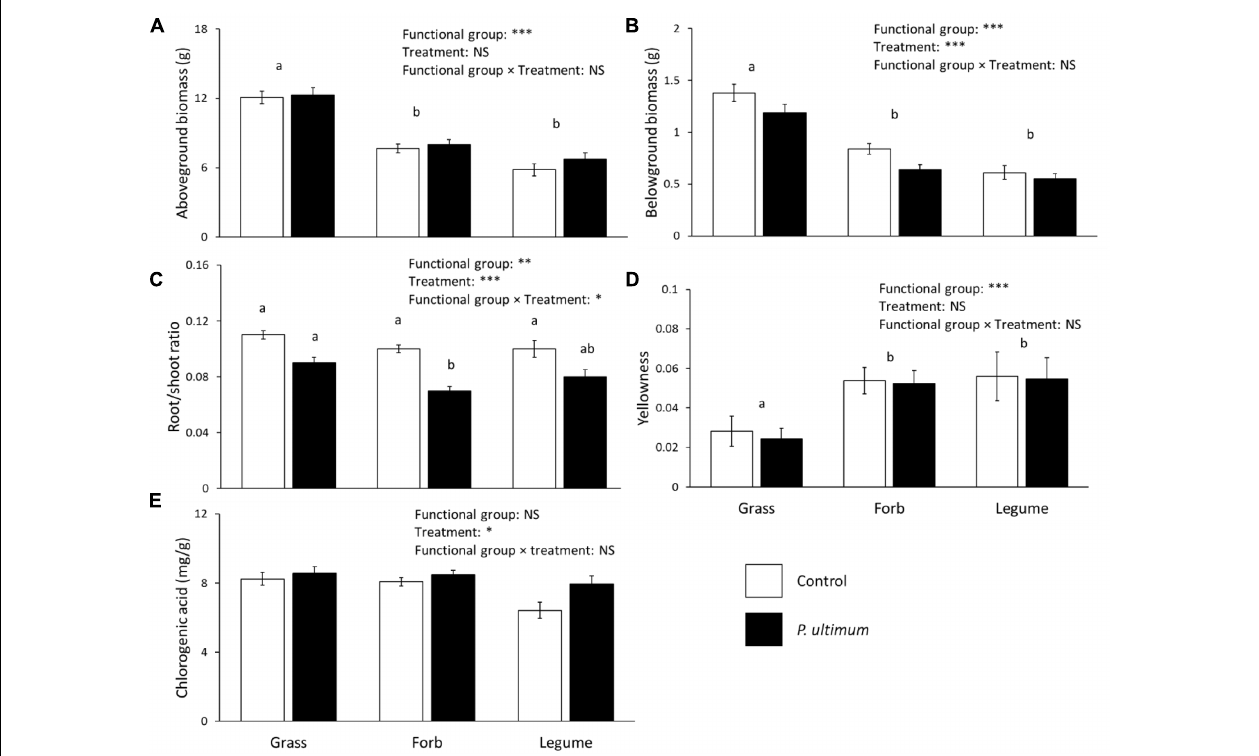
FIGURE 3 | Effects of plant functional group and pathogen addition on chrysanthemum aboveground biomass (A) , belowground biomass (B) , root/shoot ratio (C) , proportion of yellow leaves (D) , and leaf chlorogenic acid concentration (E) . Data show means ± SE, with white bars representing control soil, and black bars representing the P. ultimum treatment. Different letters indicate significant differences between functional groups ( P < 0.05). For root/shoot ratio, different letters above bars indicate significant differences ( P < 0.05). Full statistics are listed in Table 2 .